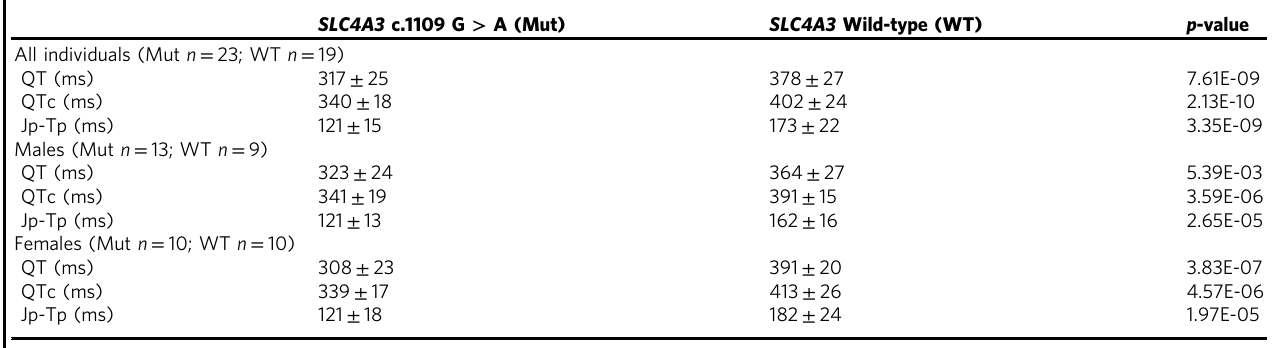
Table 1 Electrocardiographic fi ndings in SLC4A3 c.1109 G > A mutation carriers and non-carriers from a large family with short QT